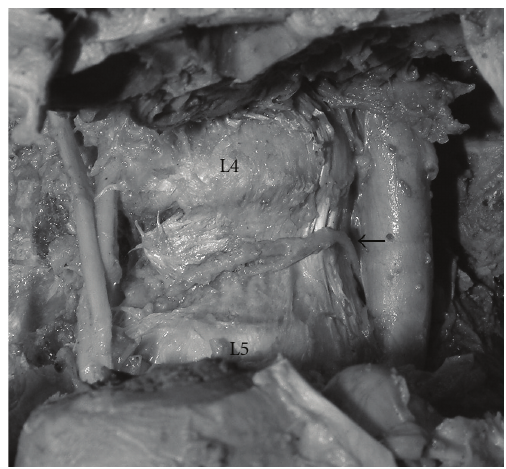
Figure 4: The lumbar arteries of L1 to L4 are small paired vessels that originate from the dorsal aspect of the abdominal aorta at the level of the transverse processes (arrow). These vessels run laterally along the bodies of the lumbar